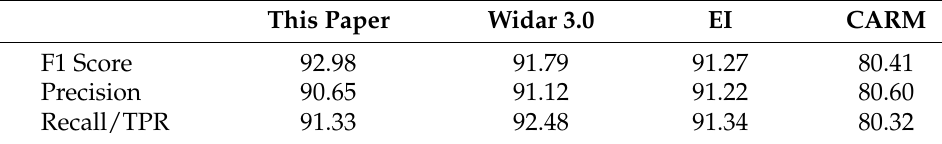
Table 2. Comparison of recognition accuracy of all models in WiDAR.